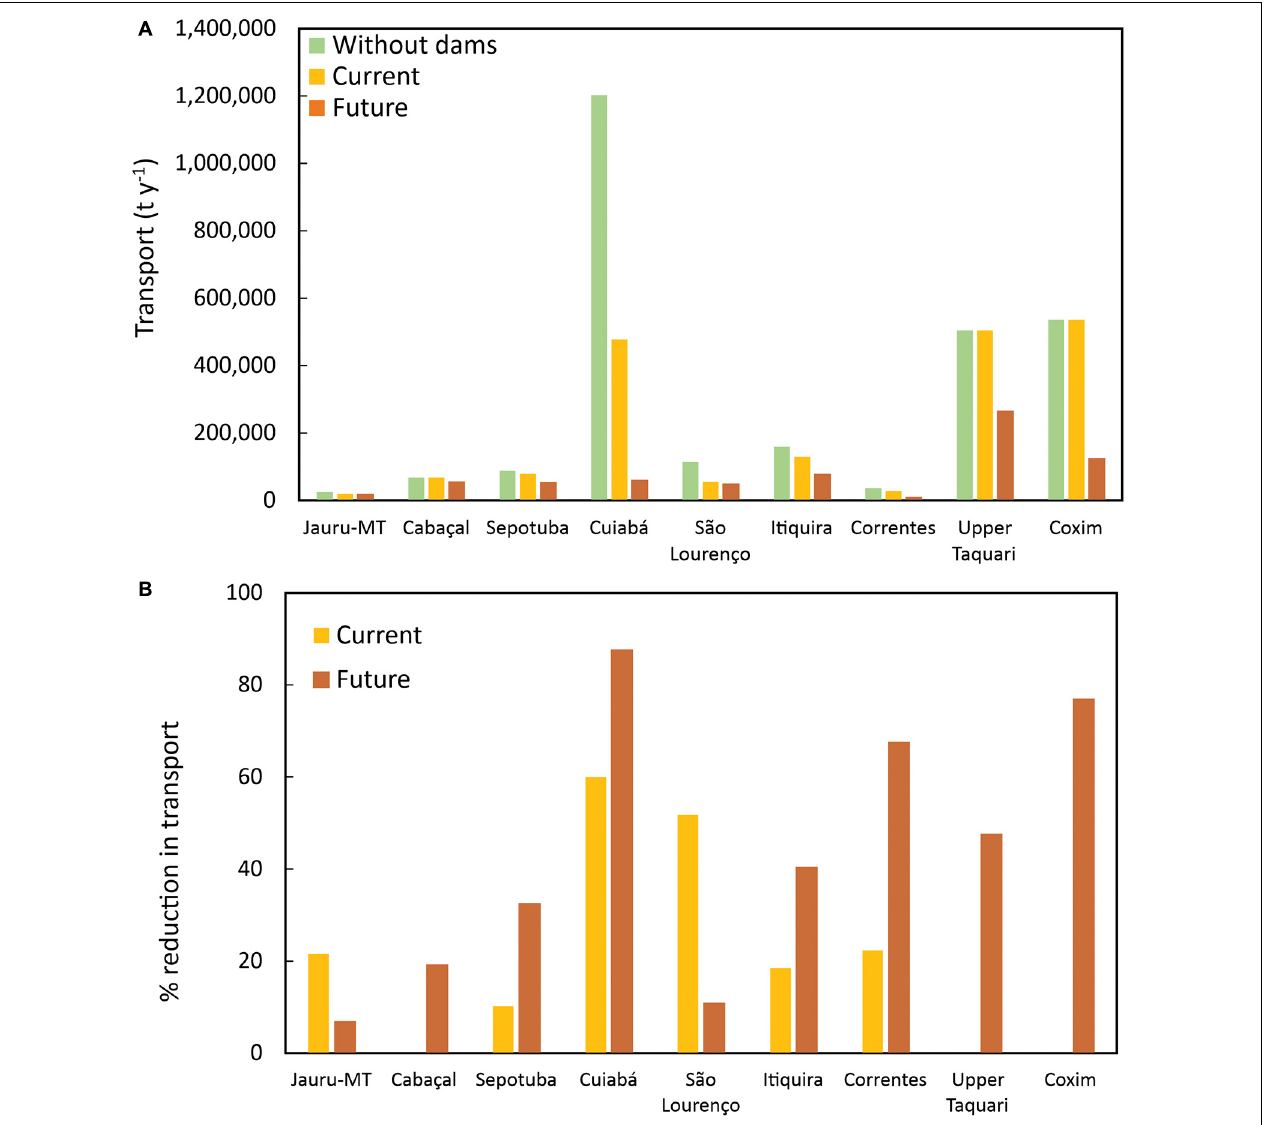
FIGURE 5 | Impacts of damming on total sediment transport to the Pantanal. (A) Annual suspended sediment transport to the Pantanal at present with and without current dams, as well as rates predicted by the neural network modeling were all future hydropower facilities to be built in each river system; (B) percent change between current rates and predicted future